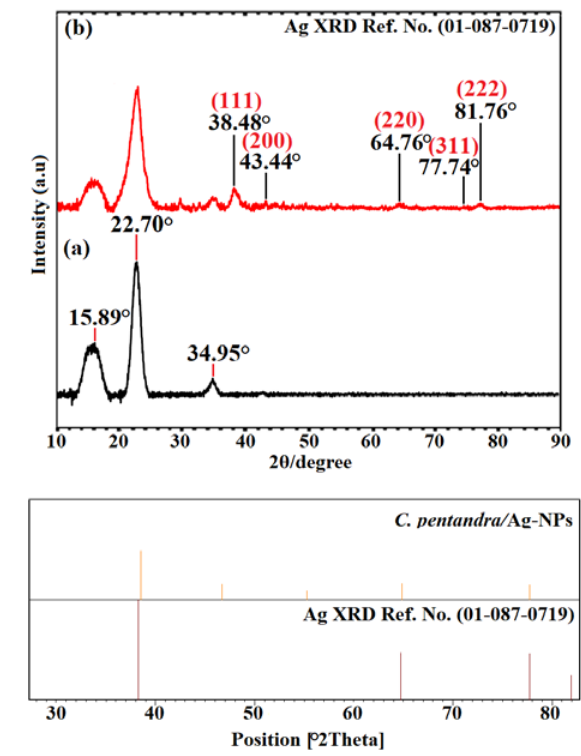
Figure 8. X-ray Diffraction (XRD) patterns of ( a ) treated C. pentandra fiber and ( b ) Ag-NPs in C. pentandra fiber.